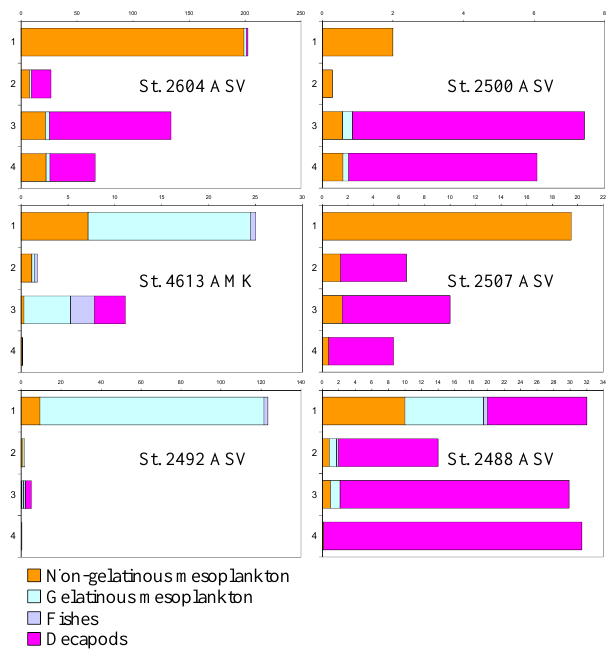
Figure 3. Wet biomass profiles (mgm − 3 ) of the main plankton groups in the epipelagic zone (1), main thermocline (2), upper bathypelagic zone (3), and lower bathypelagic zone (4) obtained during the cruises of R/V Akademik Sergey Vavilov (ASV) and R/V Akademik Mstislav Keldysh (AMK) (see also Fig. 1 and Table